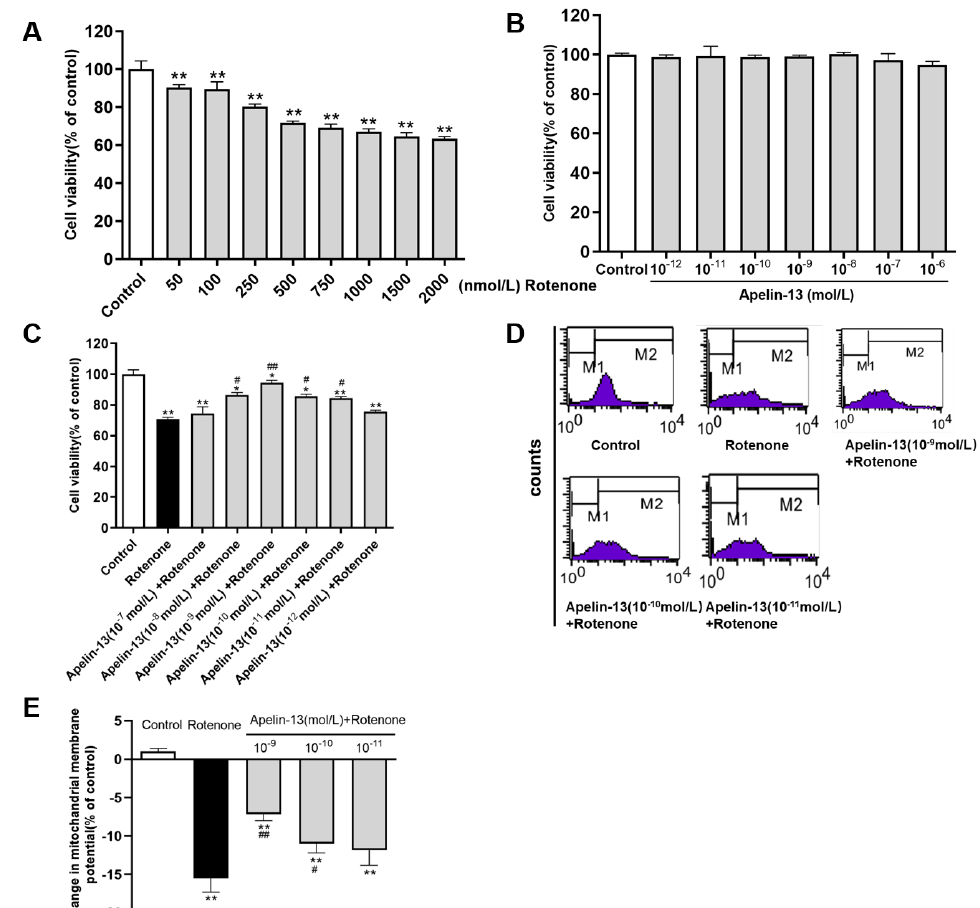
Figure 1. Cell viability and mitochondrial evaluation in SH-SY5Y cells with rotenone and